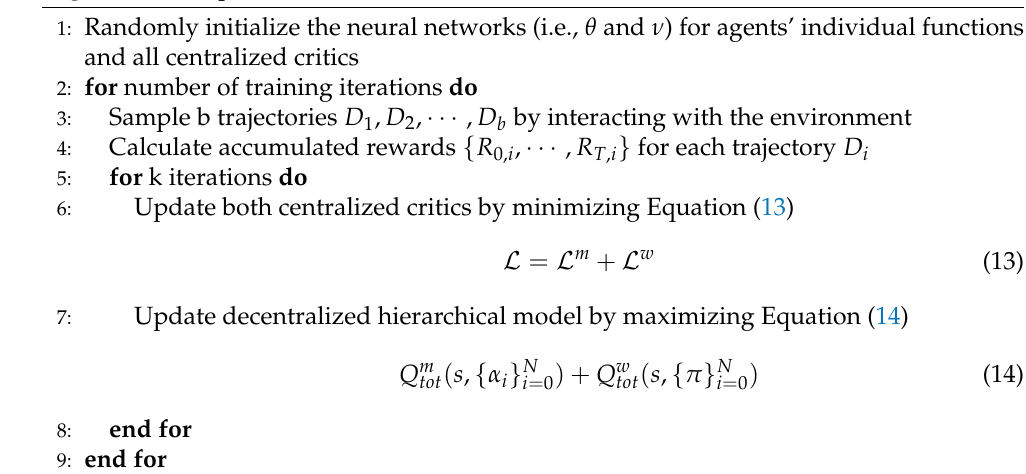
Algorithm 1 : Optimization Process for